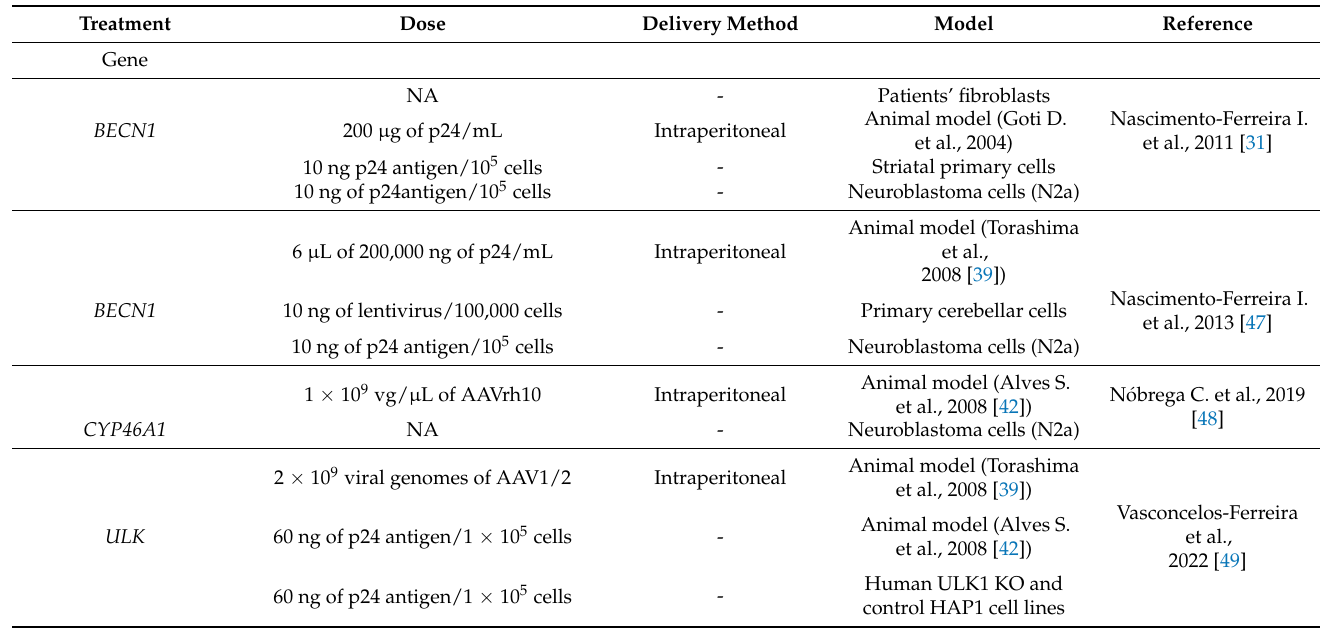
Table 4. Overview of several gene-based approaches targeting the activation of autophagy in MJD/SCA3 models.